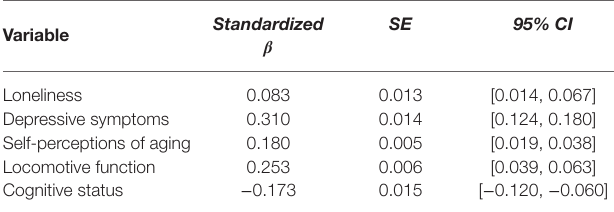
TABLE 3 | Multiple regression results for